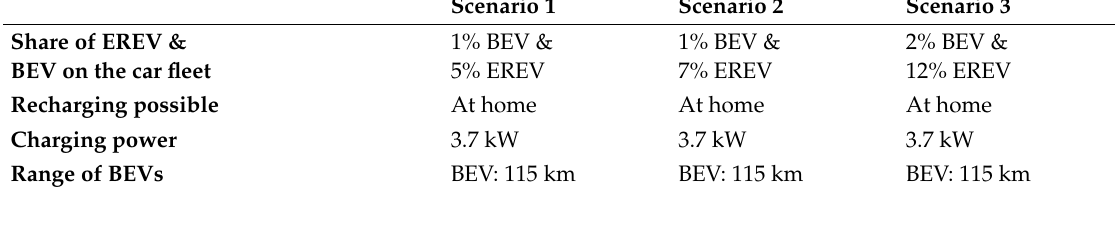
Table 3. Scenario specifications and definitions for the mobiTopp simulation